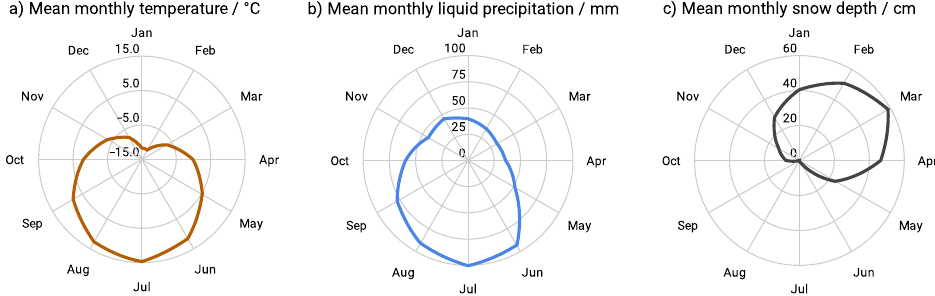
Figure 2. Mean seasonal distributions of meteo data acquired at the Monchegorsk meteo station (ID 22212) between 2005 and 2021: ( a ) mean monthly air temperatures at 2 m above ground [30]; ( b ) mean monthly precipitation [31]; ( c ) mean monthly snow depth [32]. The date range of 2005–2021 is the one for which all three measures are consistently available for this meteo station; we use wider date ranges in other figures where only temperature or precipitation are discussed.